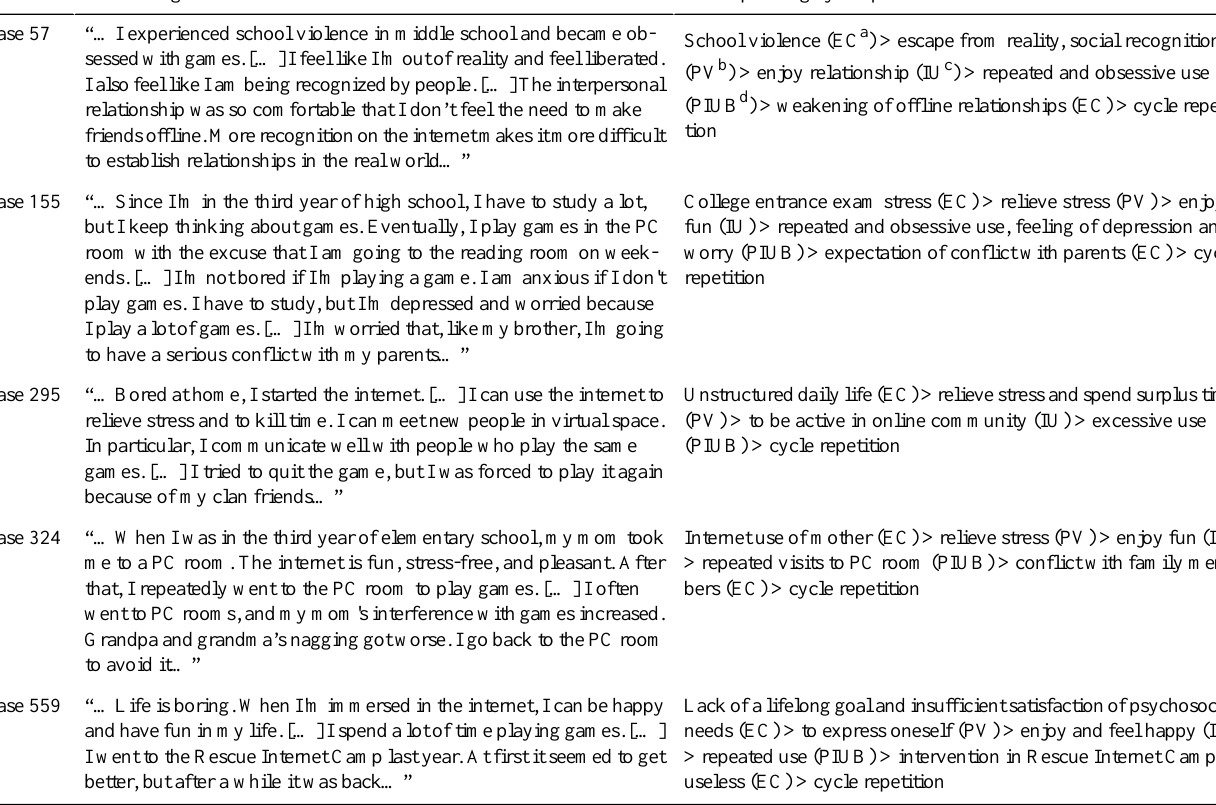
Corresponding cyclic patternCounseling contentCase